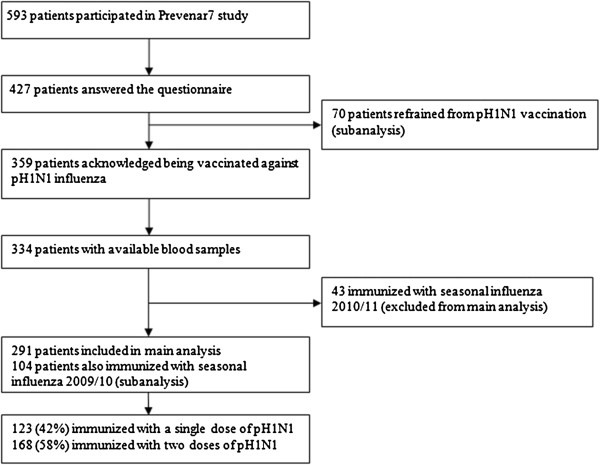
Flowchart of the study population.